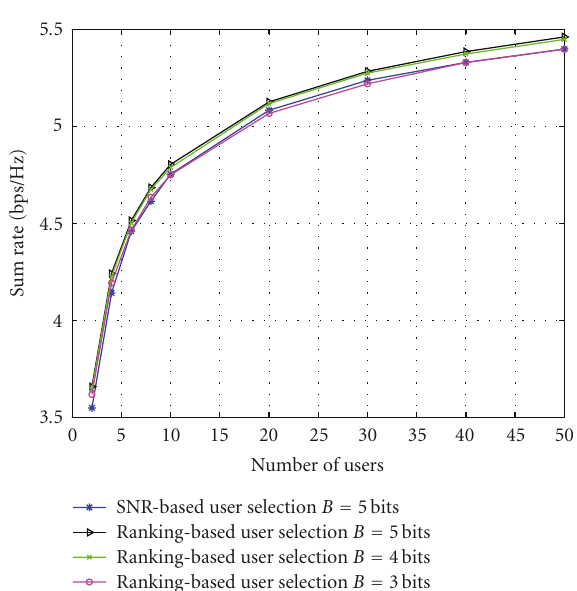
Figure 5: Average rate as a function of the number of users for single-beam RBF with M = 2 antennas, SNR = 10 dB, W = 1000 slots, and ranking-based CQI metric quantized with di ff erent number of bits. The required feedback load can be reduced with almost no expense on the system throughput achieved by quantized signal-to-noise ratio (SNR)-based user selection.